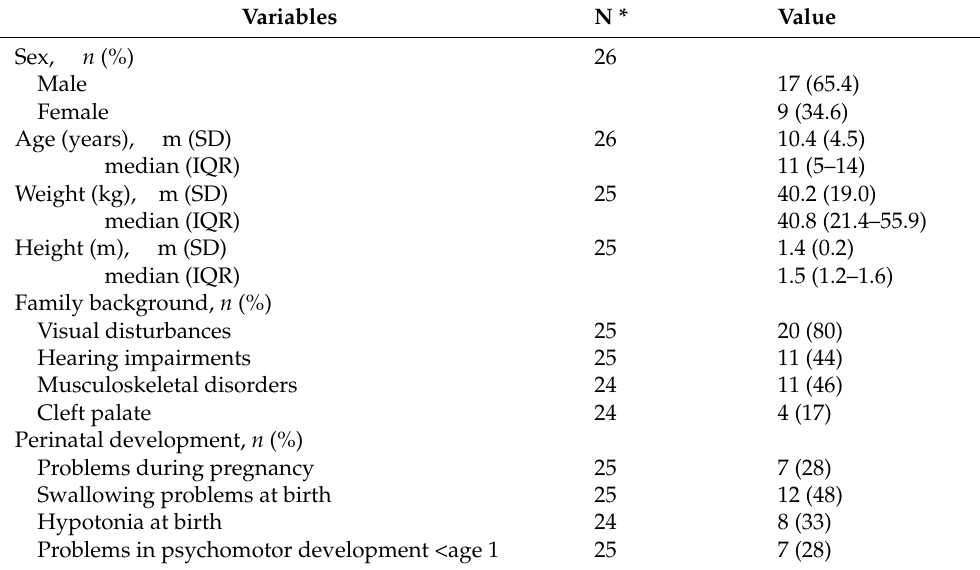
Table 1. Descriptive characteristics of the sample of children and adolescents with Stickler